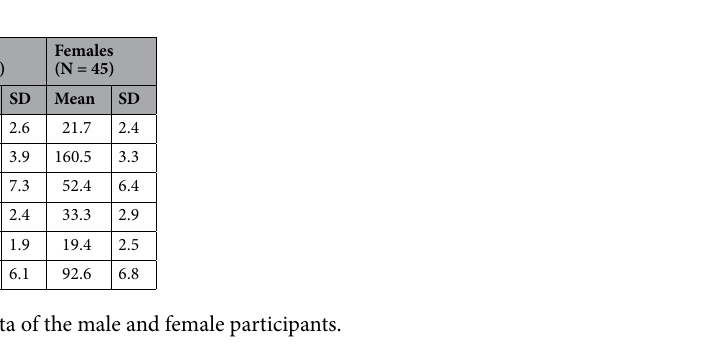
Figure 1. Schematic of the external ischial tuberosity width (EITW).